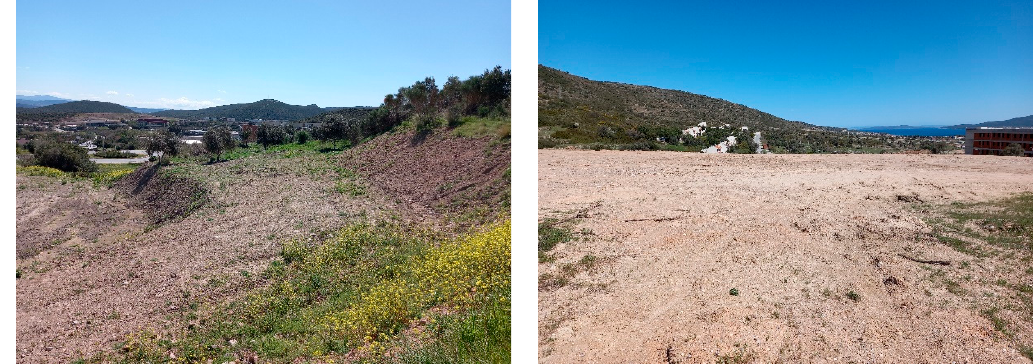
Figure 5. New terraces created in front of the Faculty of Architecture.